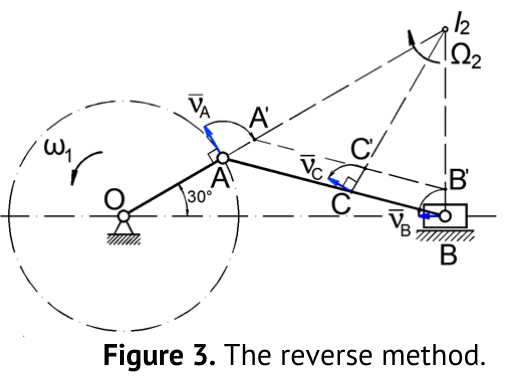
Figure 3. The reverse method.